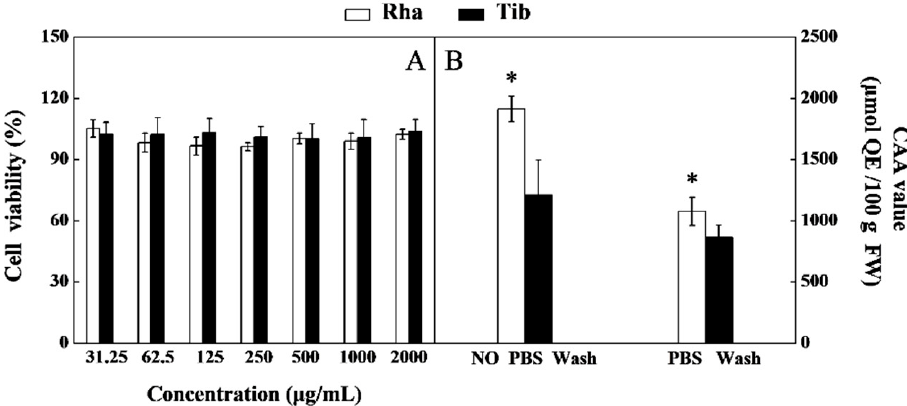
Figure 7. Cell viability ( A ) and CAA ( B ) of Rha and Tib berries. Vertical bars represent standard error of the mean ( ± SE), and the “*” indicate significant differences at p < 0.05. ( A ) Cell viability of Rha and Tib berries; ( B ) CAA of Rha and Tib berries.